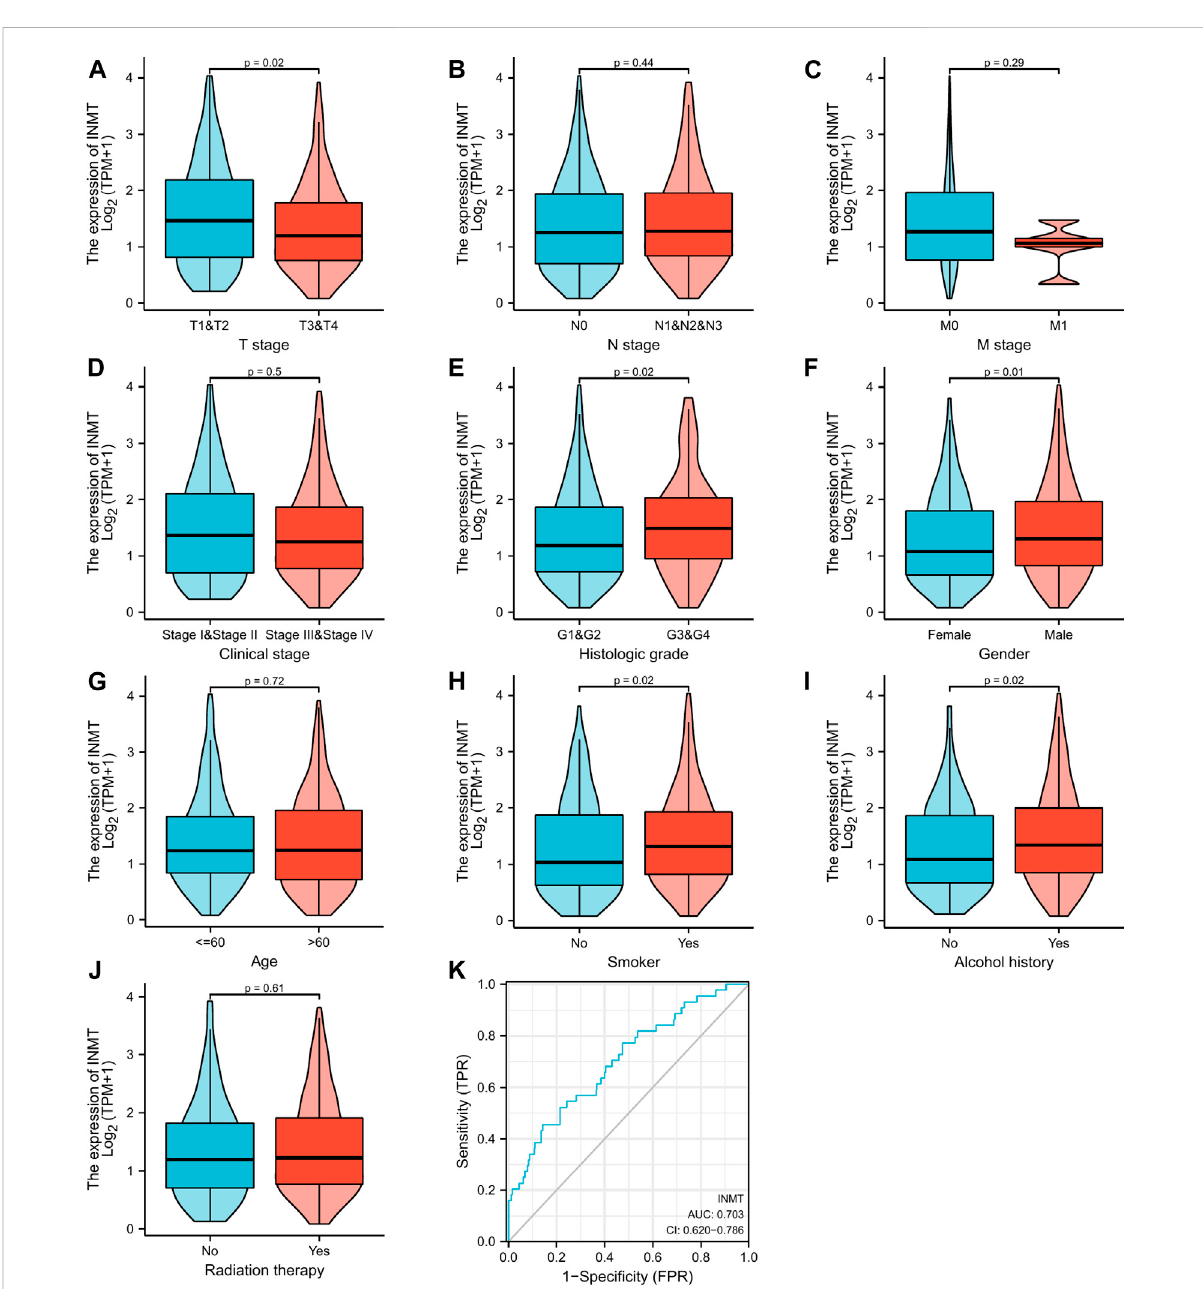
FIGURE 2 Clinical pathological characteristics correlated with INMT mRNA expression levels using the TCGA dataset. INMT mRNA expression was statistically related to T stage (A) , histologic grade (E) , gender (F) , smoke (H) , and alcohol history (I) . Nonetheless, no statistical association was discovered between the expression levels of INMT and N stage (B) , M stage (C) , clinical stage (D) , age (G) , and radiation therapy (J) . ROC analysis of INMT in HNSC (K)